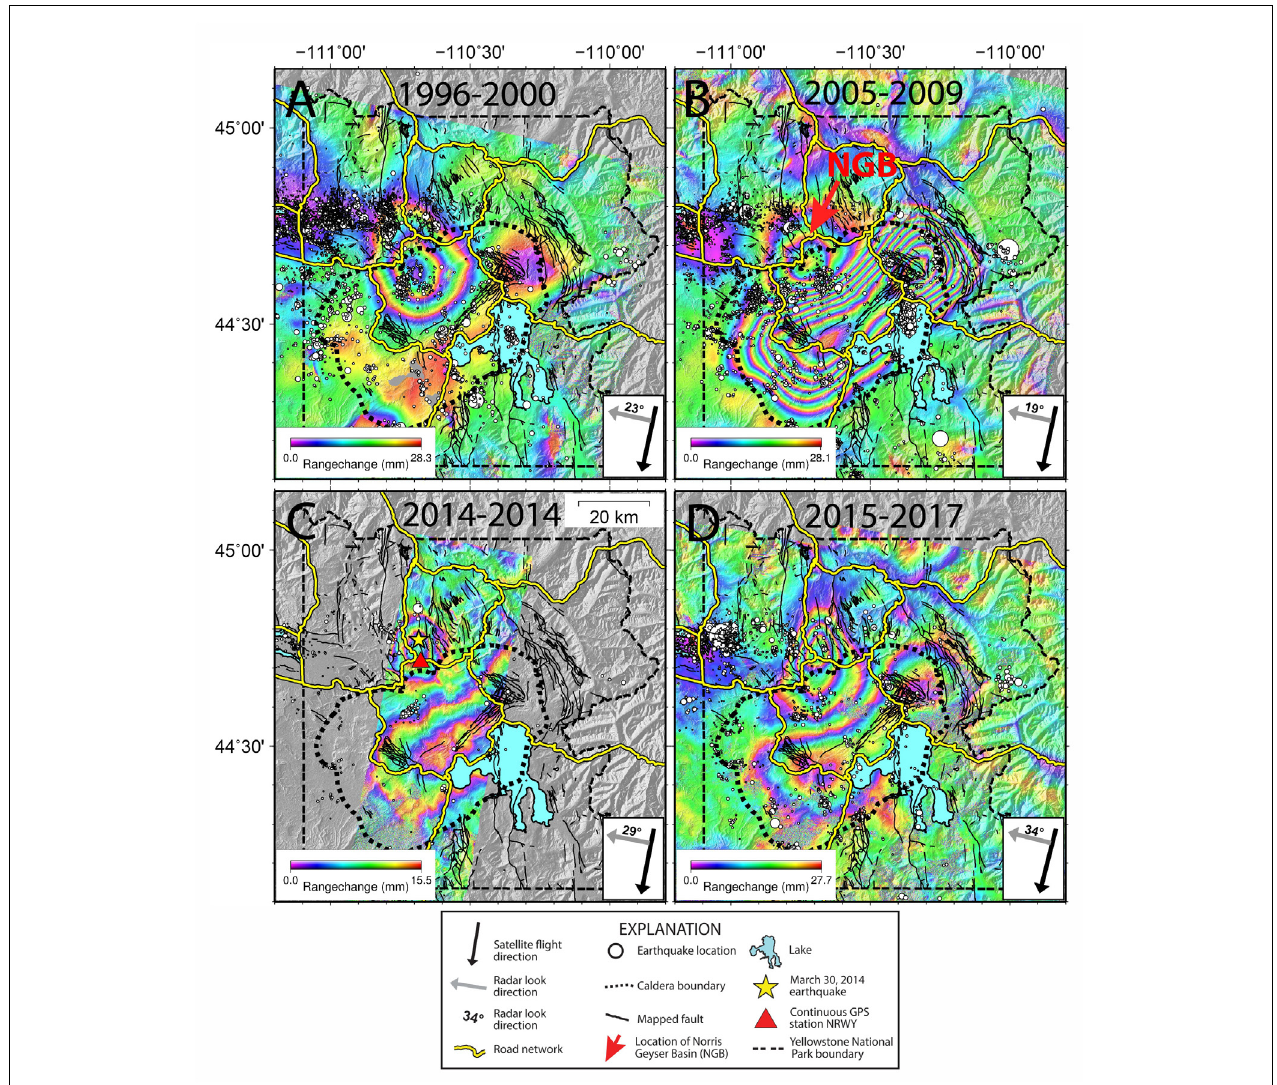
FIGURE 6 | Four interferograms representing evolution of north-rim deformation sources since 1996. Period in years spanned by each interferogram is labeled near top of each panel. Color bar showing range change mapping in each interferogram is in lower left corner of each panel and radar geometry is shown in lower right corner of each panel. Caldera boundary, Yellowstone National Park Boundary, and mapped faults are from Christiansen (2001). Earthquake circle size is scaled to magnitude. (A) ERS-2 interferogram from 19960919 to 20000928. (B) ENVISAT interferogram from 20050802 to 20090811. (C) TerraSARX interferogram from 20140609 to 20141008. The 20 km length scale in upper right of panel C applies to all panels. (D) Sentinel 1 interferogram from 20150727 to